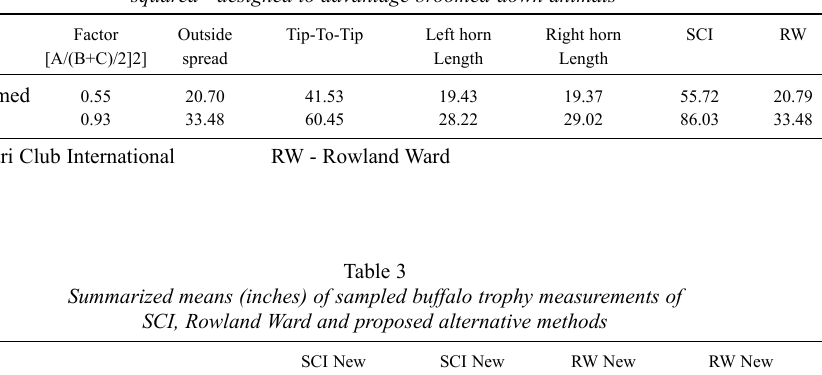
Table 2 Various horn parameters (inches) and resulting SCI and Rowland Ward scores after application of an index (dividing the tip space measurements by the mean of the two individual horn lengths squared), the quantity squared - designed to advantage broomed-down